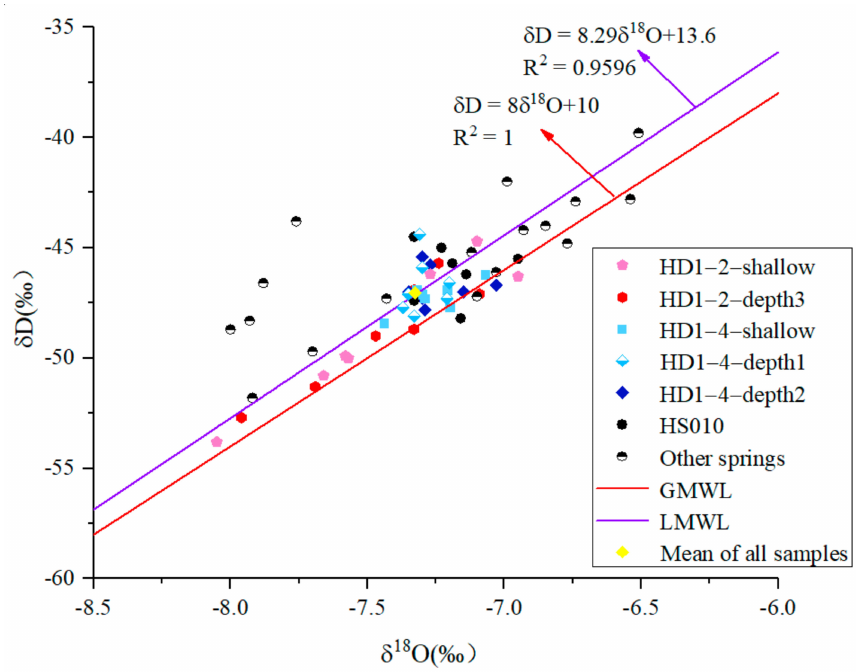
Figure 6. Plot of δ D versus δ 18 O for groundwater samples—-the relationship between the distribution area of various types of water samples and GMWL and